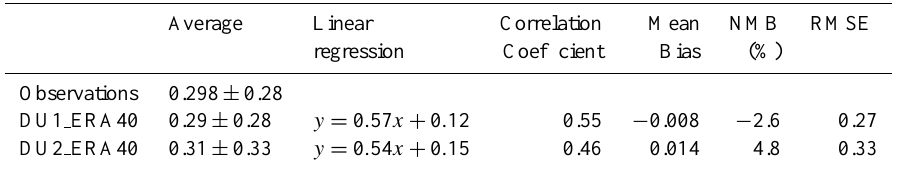
Fig. 9. Comparison of modelled and measured annual dust deposition (gm − 2 yr − 1 ) from 84 stations. The stations are shown in Figure 3b and the colour of the dots corresponds to the location of each station. E-Pacific = red, W-Pacific = orange, S-Africa = blue, Atlantic = green, Australia = yellow, Asia = pink, S-Ocean = grey. The dotted lines denote the 1 : 10 to 10 : 1 range. Table 9. Statistics of the daily average AOD for 19 AERONET